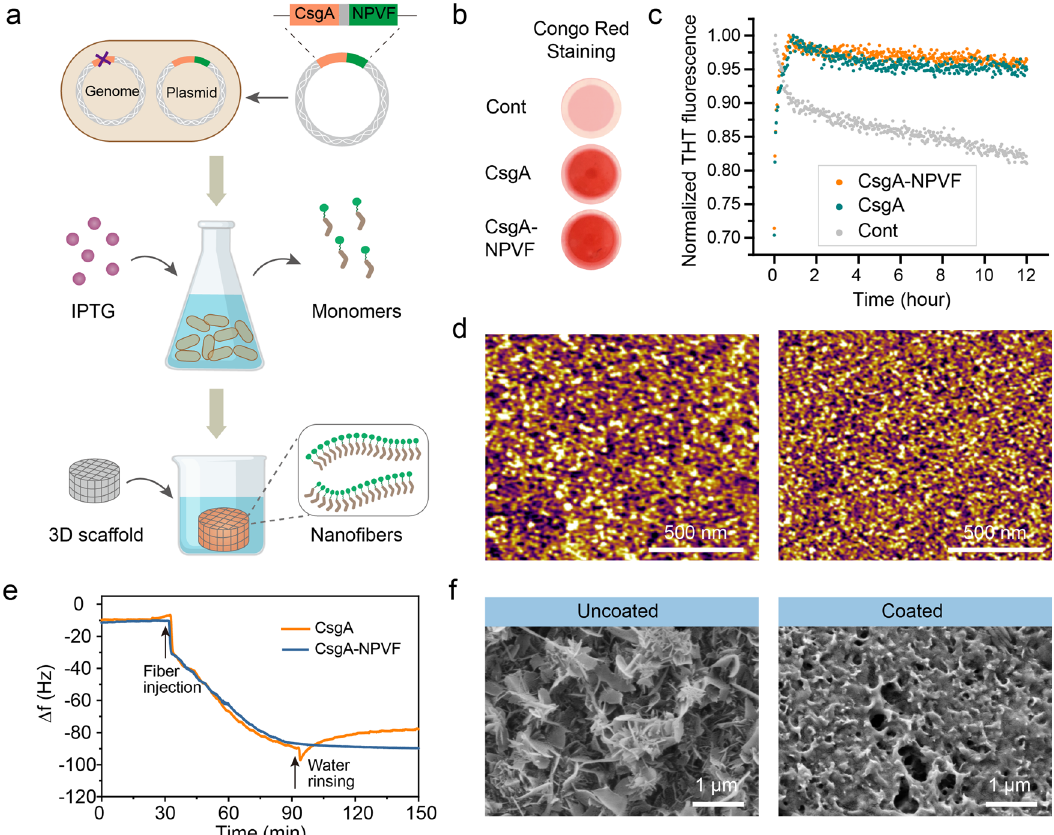
Fig. 5 Preparation and characterization of the CsgA-NPVF nano fi ber coating. a Schematic diagram depicting the induction of recombinant protein expression by Isopropyl ß-D-1-thiogalactopyranoside (IPTG) and the preparation of nano fi ber coatings on a porous 3D HAp scaffold. b Congo red staining of the puri fi ed CsgA and CsgA-NPVF nano fi bers. c Assembly kinetics of CsgA and CsgA-NPVF monomer solutions monitored by ThT fl uorescence assay. The imidazole buffer used to elute the target proteins during protein puri fi cation was used as a control for Congo red staining and ThT fl uorescence assay. d AFM images showing the morphology of the self-assembled protein nano fi bers. e Comparison of the adsorption behavior of the CsgA and CsgA-NPVF nano fi bers on HAp substrates measured by QCM. f SEM images showing the surface morphology of the 3D HAp scaffold before and after the coating